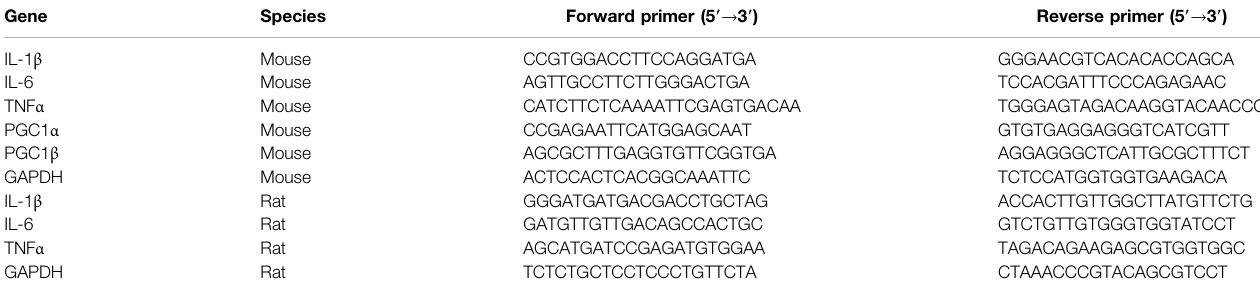
TABLE 1 | Primers used for